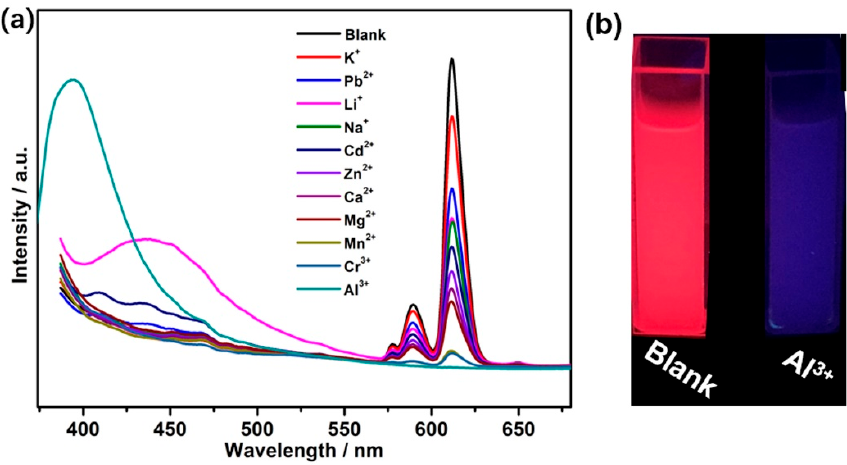
Figure 7. ( a ) Photoluminescence spectra ( λ ex = 367 nm) of hybrid material Eu(tta) 3 bpdc-SiO 2 @mTiO 2 after dispersed in ethanol solutions of different metal ions and ( b ) pictures of hybrid material Eu(tta) 3 bpdc-SiO 2 @mTiO 2 under the 365 nm UV lamp after dispersed in ethanol solutions without and with Al 3+ ions.